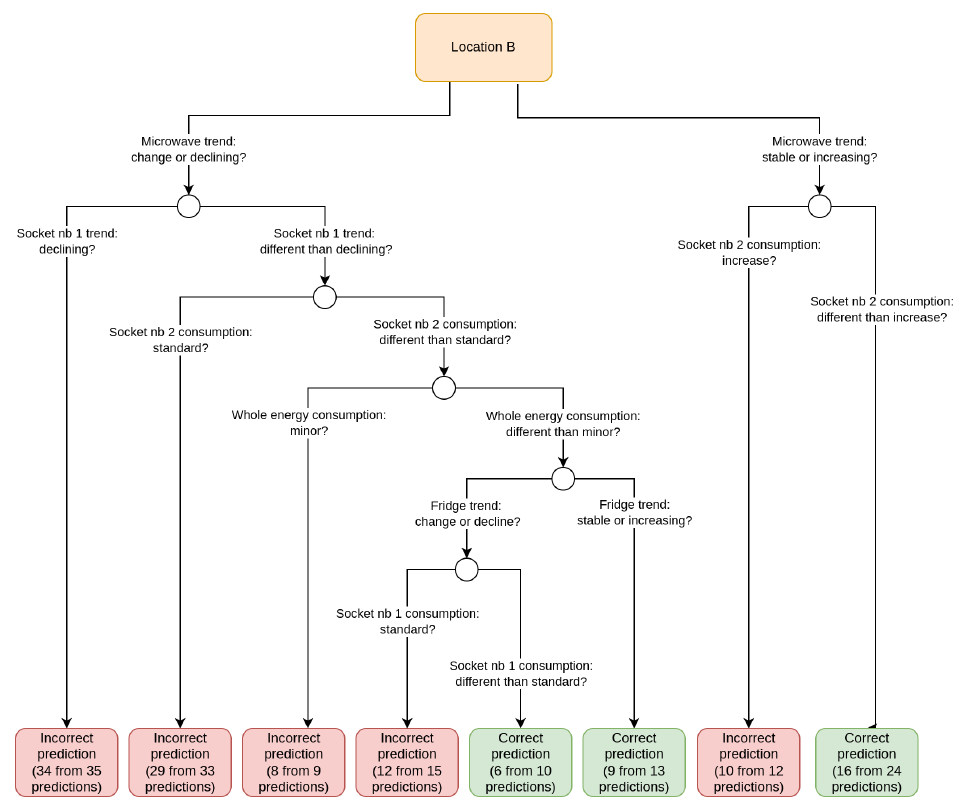
Figure 3. Decision tree explaining when the device_prophet models made mistakes for location